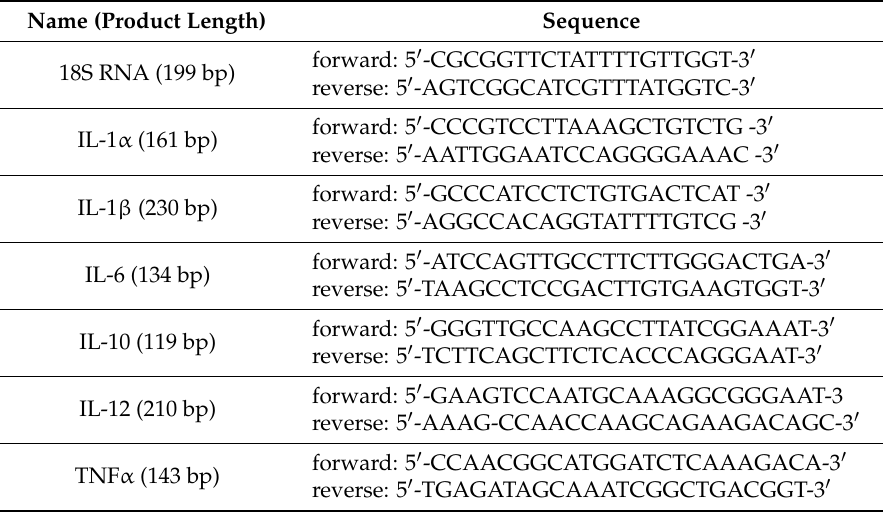
Table 2. Sequence of primers used for qRT-PCR